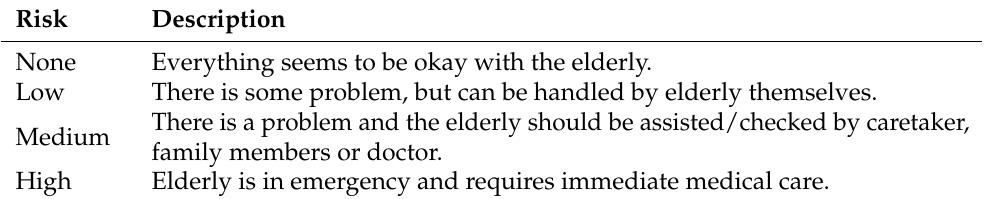
Table 2. Risks used in the application and their